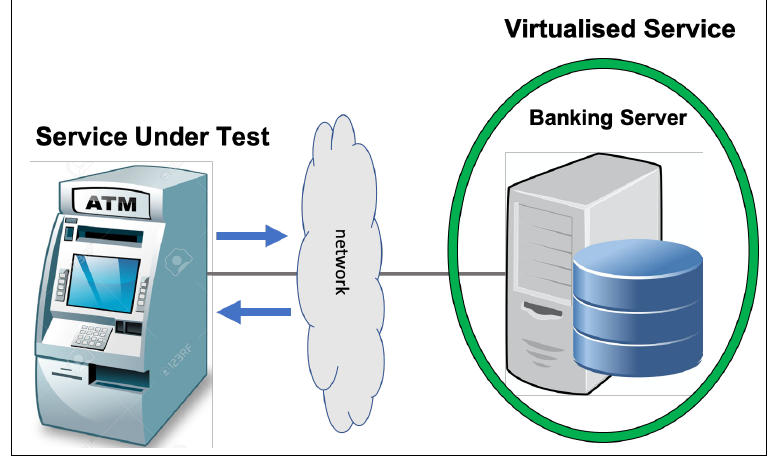
Figure 6. Banking scenario.